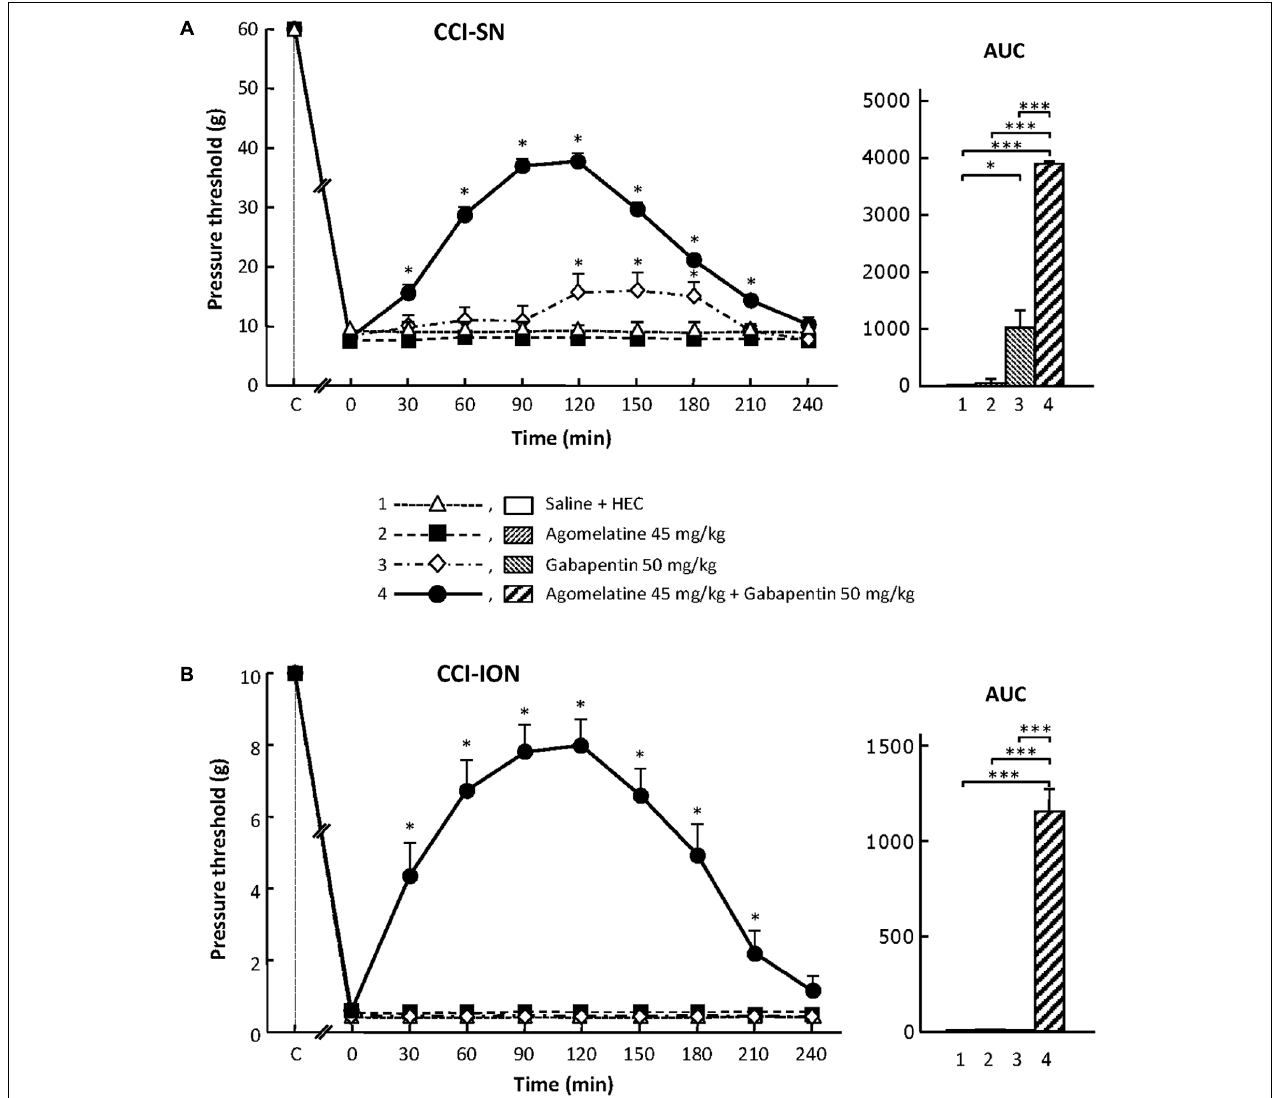
FIGURE 1 | Effects of agomelatine, gabapentin and their combination on mechanical allodynia in CCI-SN (A) and CCI-ION (B) rats. Left panels: Agomelatine (45 mg/kg), gabapentin (50 mg/kg), agomelatine + gabapentin and/or respective vehicles (saline, HEC) were injected i.p. 2 weeks after nerve ligation. Pressure threshold values (as g) were determined using von Frey filaments applied onto the ipsilateral hindpaw (A-CCI-SN) or vibrissal pad (B-CCI-ION) at various times after injections (abscissa). Each point is the mean ± SEM of n independent determinations. ∗ P < 0.05, compared with pressure threshold values determined just prior to drug injection (0 on abscissa), one way ANOVA with repeated measures, Dunnett’s test. C on abscissa: intact healthy rats before surgery. Right panels : AUC values calculated from the respective time-course curves: (1) saline + HEC [ n = 25 (A) , n = 13 (B) ]; (2) agomelatine + saline ( n = 7/5); (3) gabapentin + HEC ( n = 9/6); (4) agomelatine + gabapentin ( n = 40/28). A- CCI-SN : one way ANOVA [ F (3,77) = 92.39, P < 0.0001] followed by Tukey’s test ( ∗ P < 0.05, ∗∗∗ P < 0.001); B- CCI-ION: one way ANOVA [ F (3,48) = 24.19, P < 0.0001] followed by Tukey’s test ( ∗∗∗ P <